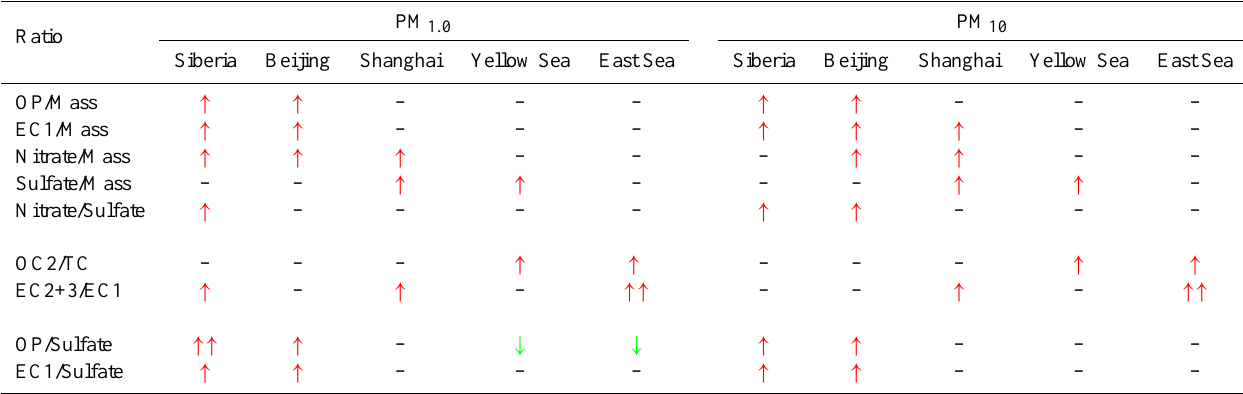
Table 6. Ratios of major chemical constituents indicating source regions categorized into 5 regimes: Siberia, Beijing, Shanghai, Yellow Sea, and East Sea.